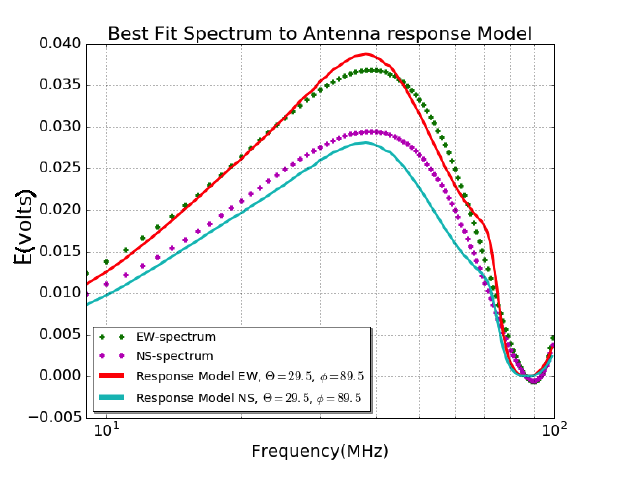
Figure 8. The comparison between the response model V e w/ ns (ˆ θ, ˆ φ, f ) and the V spectrum ( f ) for a cosmic event. ˆ θ and ˆ φ e w/ ns denote the estimated values from the minimization procedure shown in figure 7 (ˆ θ = 29 . 5 o , ˆ φ = 89 . 5 o ). The green (magenta) crosses is the EW (NS) spectrum and the red (light blue) line the EW (NS) VRM.